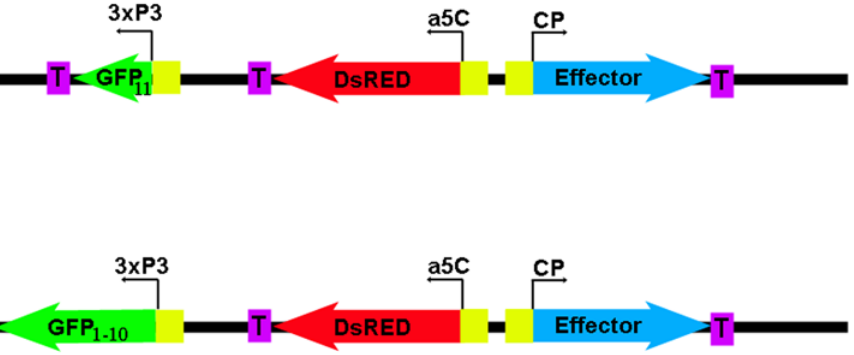
Figure 8. Potential strategy using a self-assembling fluorescent reporter protein to visually identify mosquitoes carrying 1 vs. 2 inserts at a specific genomic phi C31 location. Mosquitoes heterozygous for each individual transgene (identified by constitutive DsRED fluorescence) are crossed. F1 mosquitoes inheriting a transgene copy from each parent exhibit eye-specific (3xP3) GFP expression. When GFP- expressing F1 mosquitoes are crossed, all subsequent generations will be homozygous for the effector transgene. CP=bloodmeal-induced carboxypeptidase promoter, aC5=constitutive actin5C promoter, T=terminator.